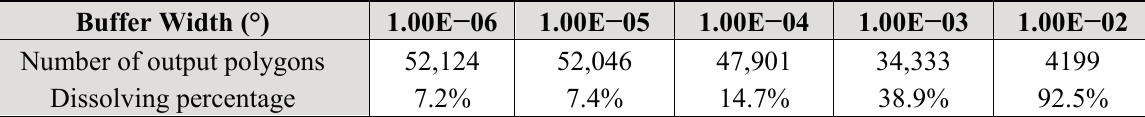
Table 3. Number of the output polygons with different buffer